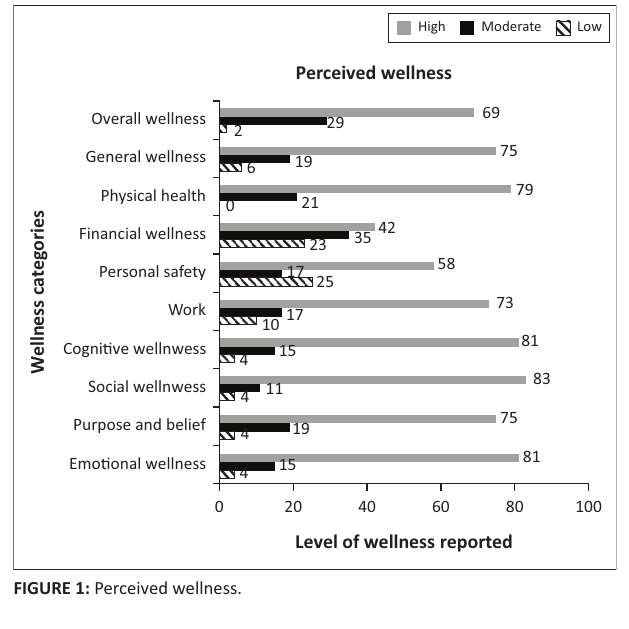
FIGURE 1: Perceived